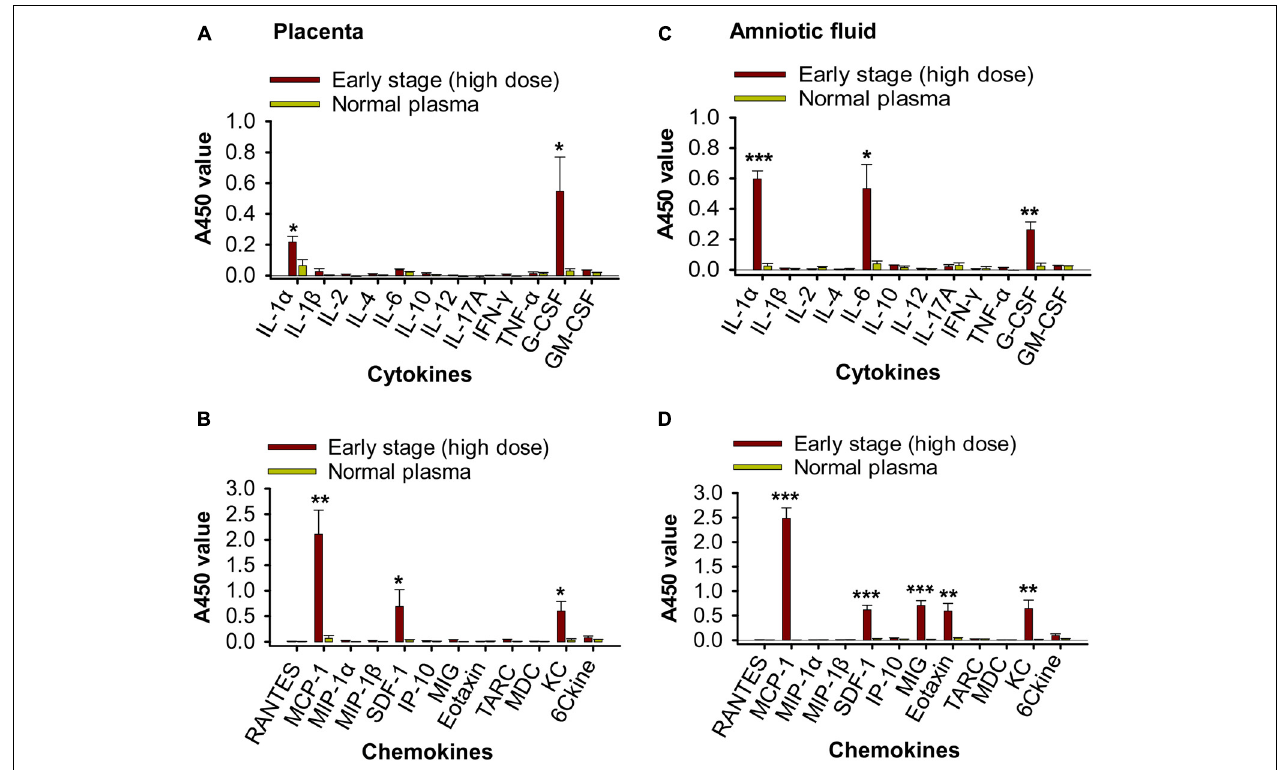
FIGURE 7 | Transfusion of pregnant A129 mice with early-stage (high dose) ZIKV + plasma led to significant inflammation. Placentas (A,B) and amniotic fluid (C,D) collected from pregnant (E10–12) A129 mice 6 days post-transfusion of early-stage (high dose) ZIKV + plasma were detected by Multi-Analyte ELISArray Kits for inflammatory cytokines (A,C) and chemokines (B,D) . ∗ , ∗∗ , and ∗∗∗ indicate significant differences between early stage (high dose) and normal plasma groups, and the data are presented as means ± s.e.m ( n = 6 mice/group). Normal plasma: control plasma from A129 mice transfused with normal plasma without